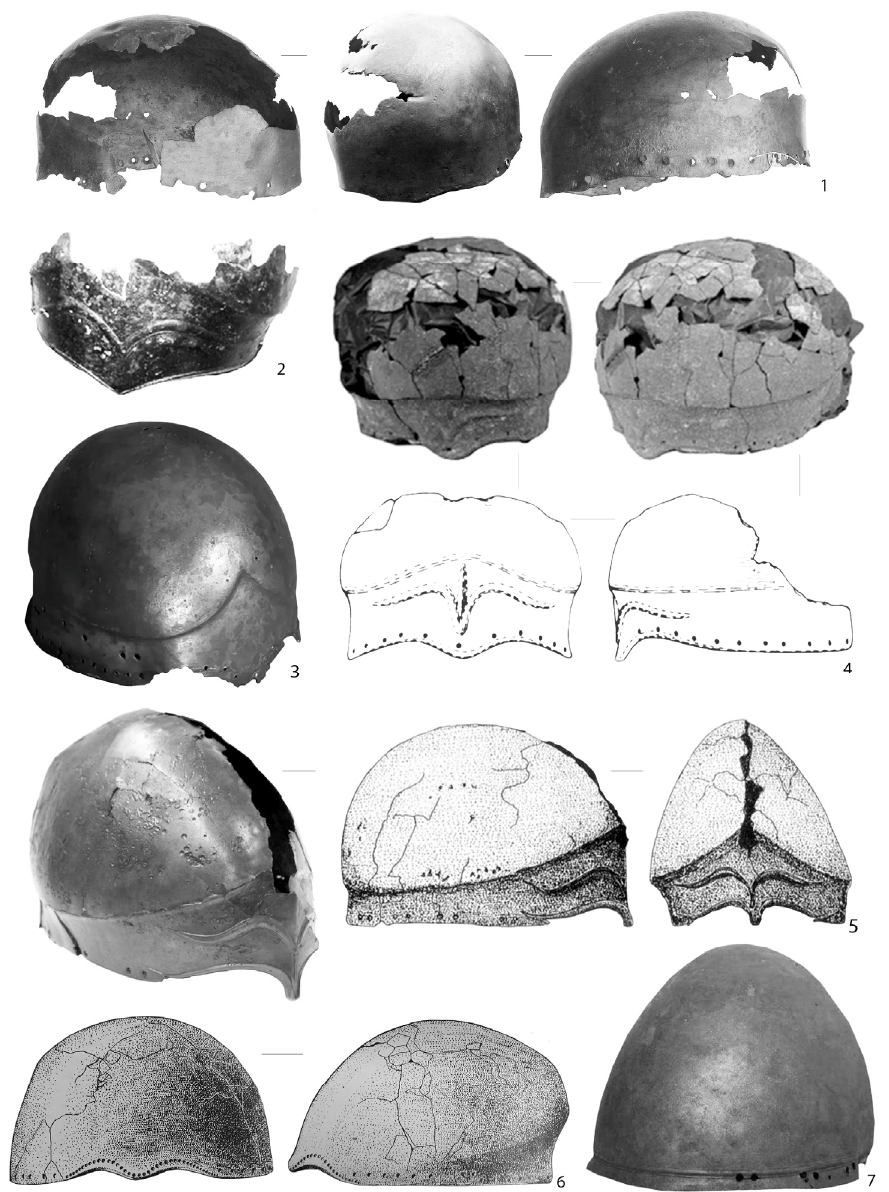
Figure 17. Trimmed helmets. (1)—Nadezhda (after: Polin and Koltukhov 2014); (2)—Talaevski kurgan (after: Koltukhov and Senatorov 2015); (3)—Solokha (after: Mantsevich 1987, cat. 35); (4)—Artsyz (after: ˇCernenko 2006, cat. 600; Alekseeva et al. 2021); (5)—Konski Razdory (after: Pleshivenko 2013); (6)—Nikolskoe (after: Zasetskaya 1977, fig. 28); (7)—Kardashinka (after: ˇCernenko 2006, cat. 610; Kostenko and Abikulova 2016).